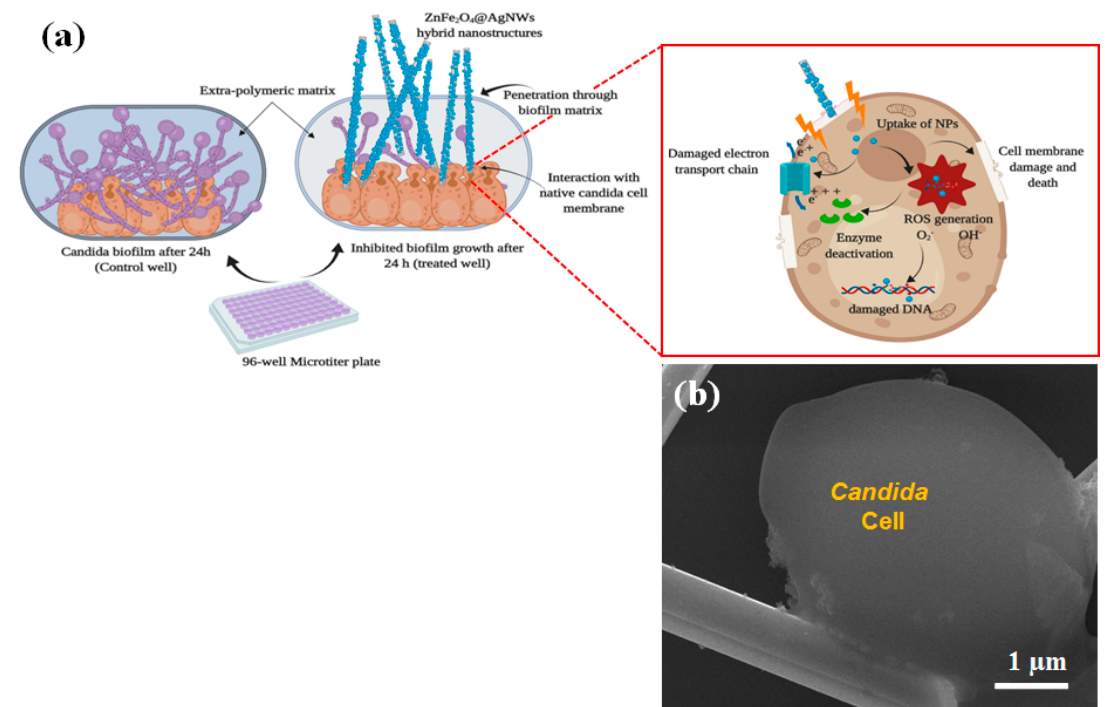
Figure 7. ( a ) Schematic illustration of the biofilm inhibition mechanism. ( b ) High-resolution SEM image of Candida biofilm treated with ZnFe 2 O 4 @AgNWs hybrid nanostructures (100 µg/mL) after 24 h of biofilm formation.